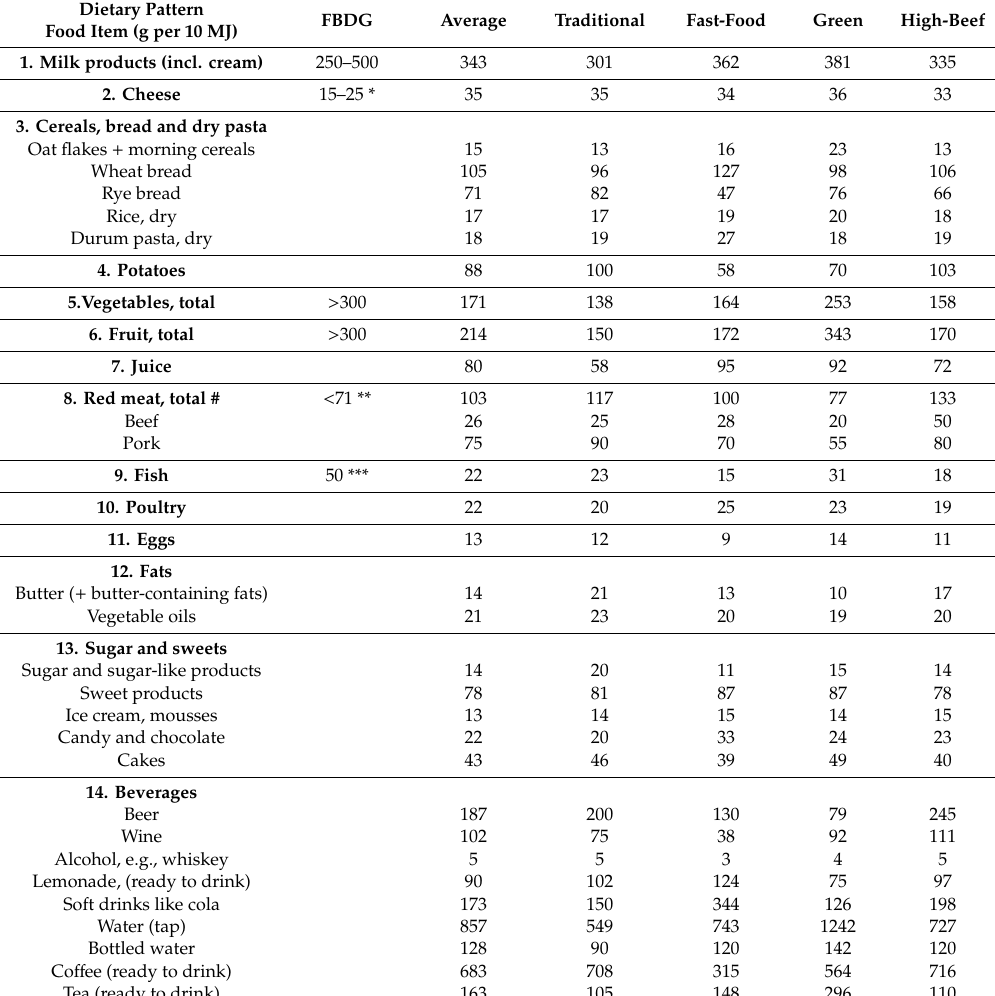
Table 4. Average food content (g) of di ff erent dietary patterns for adult persons scaled to an energy intake per day of 10 MJ, g / day and Danish Food-Based Dietary Guidelines (FBDG) [77]. Dietary Pattern FBDG Average Traditional Fast-Food Green Food Item (g per 10 MJ)